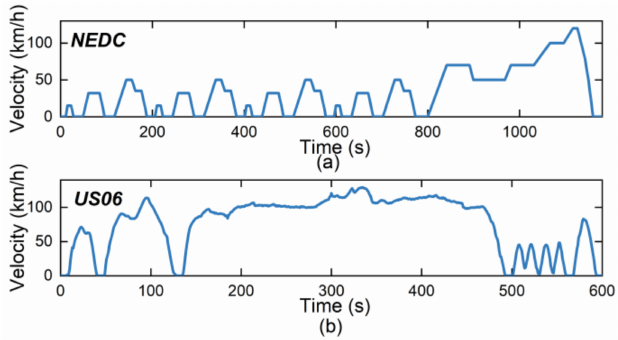
Figure 14. Velocity distribution of driving cycles. ( a ) NEDC; ( b )